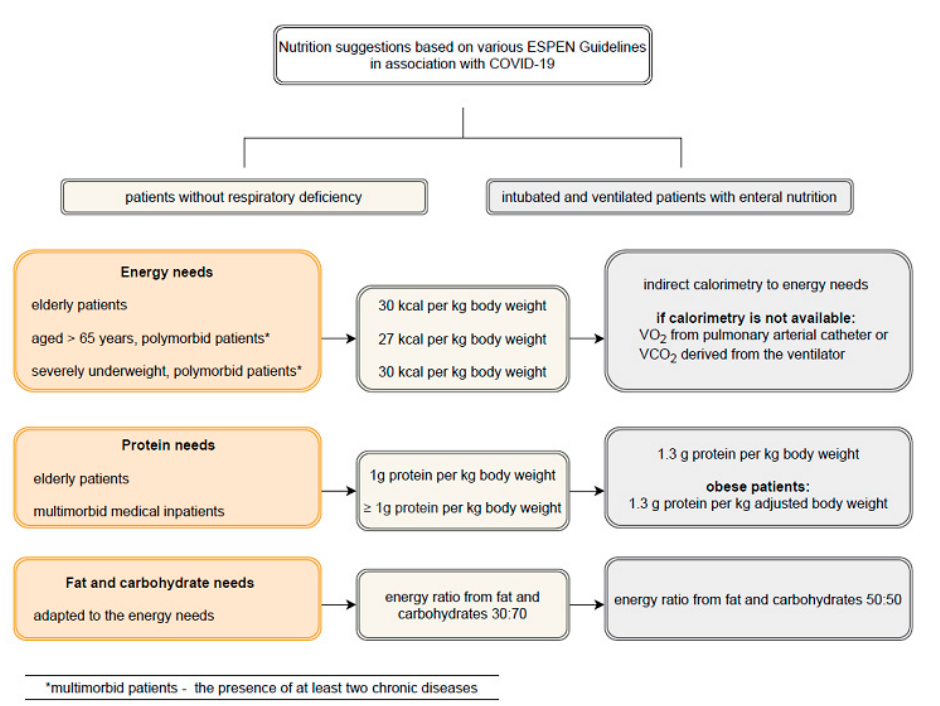
Figure 1. Nutritional suggestions based on the ESPEN Guidelines in association with COVID-19 [8].